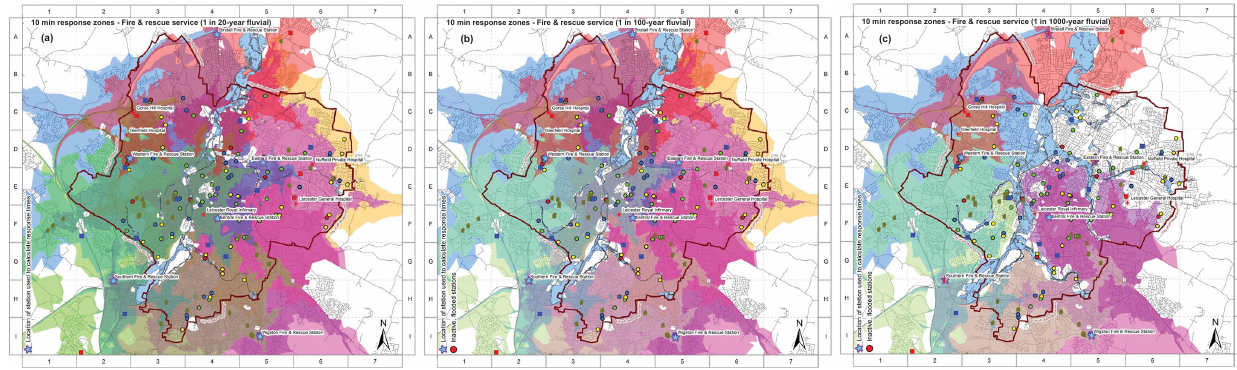
Figure 12. City-scale accessibility (within a 10min time frame) for fire and rescue service stations under (a) 1 in 20-year, (b) 1 in 100-year and (c) 1 in 1000-year fluvial flooding scenarios. Refer to the key in Fig. 6.